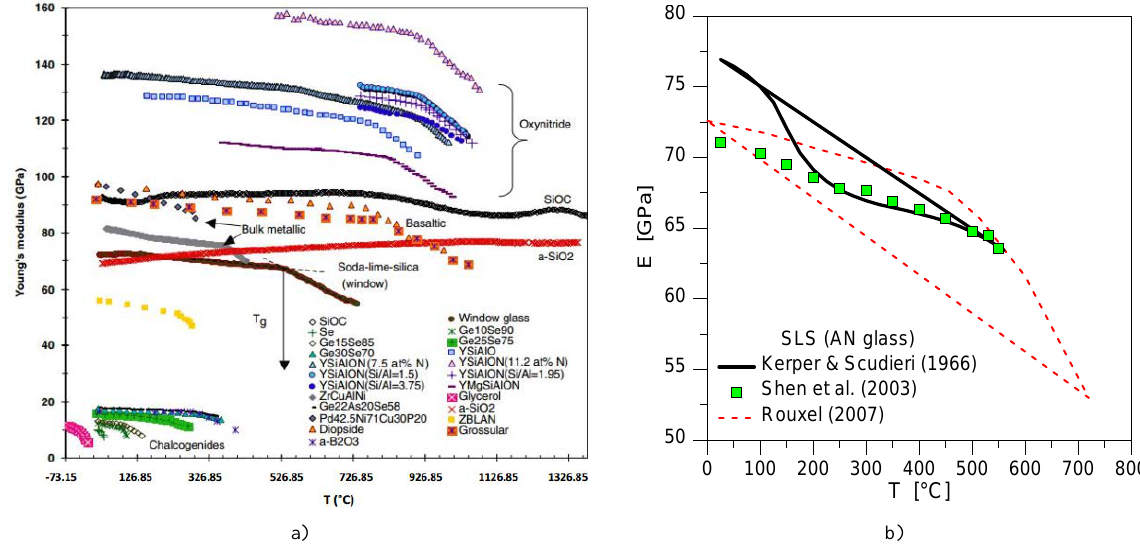
Fig. 1 MOE variation in glass, as a function of temperature, with evidence of a) several glass types (Rouxel, 2007) or b) SLS glass